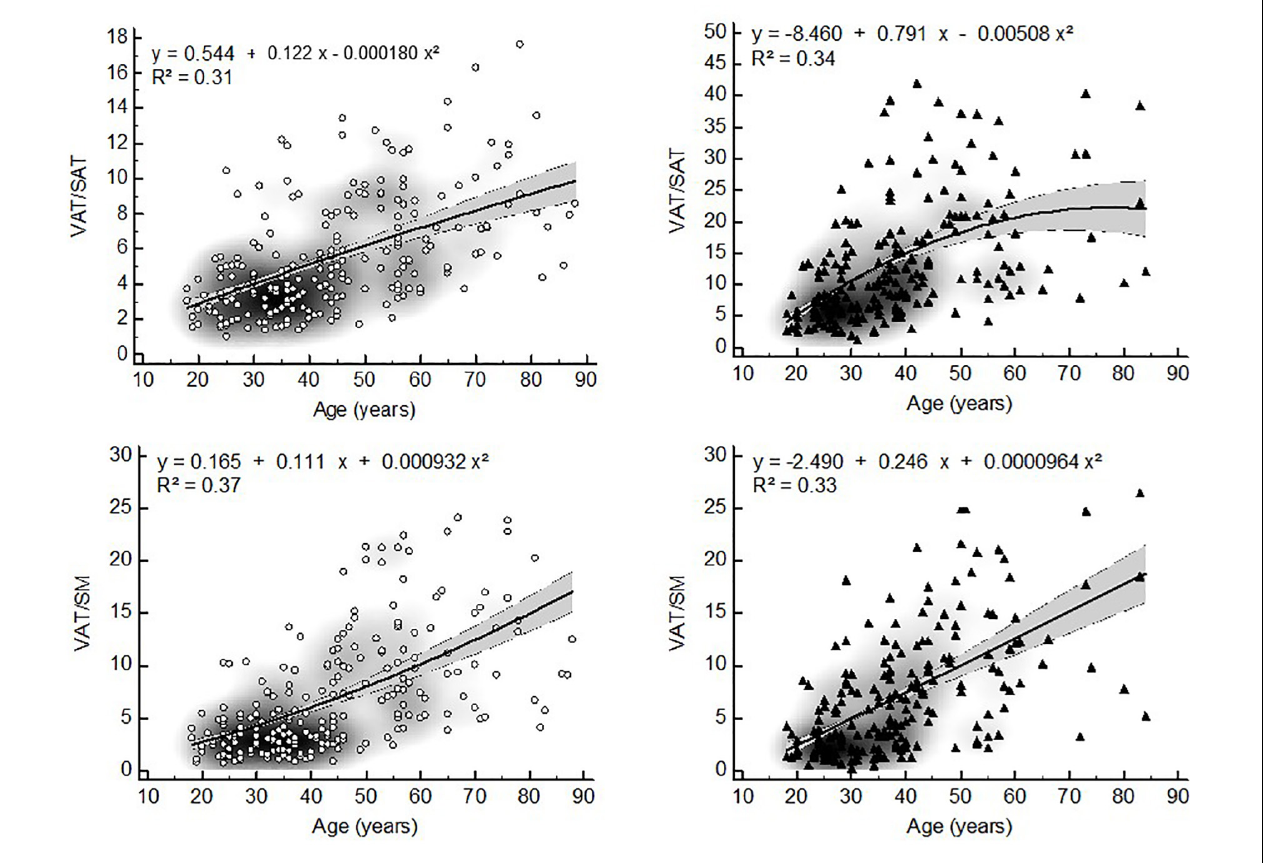
FIGURE 1 | Non-linear relationships between VAT distribution ratios and age ( (cid:78) = women, (cid:78) = men, VAT = visceral adipose tissue, WHR = waist-to-hip ratio, WC = waist circumference, gray zone represents 95% confidence